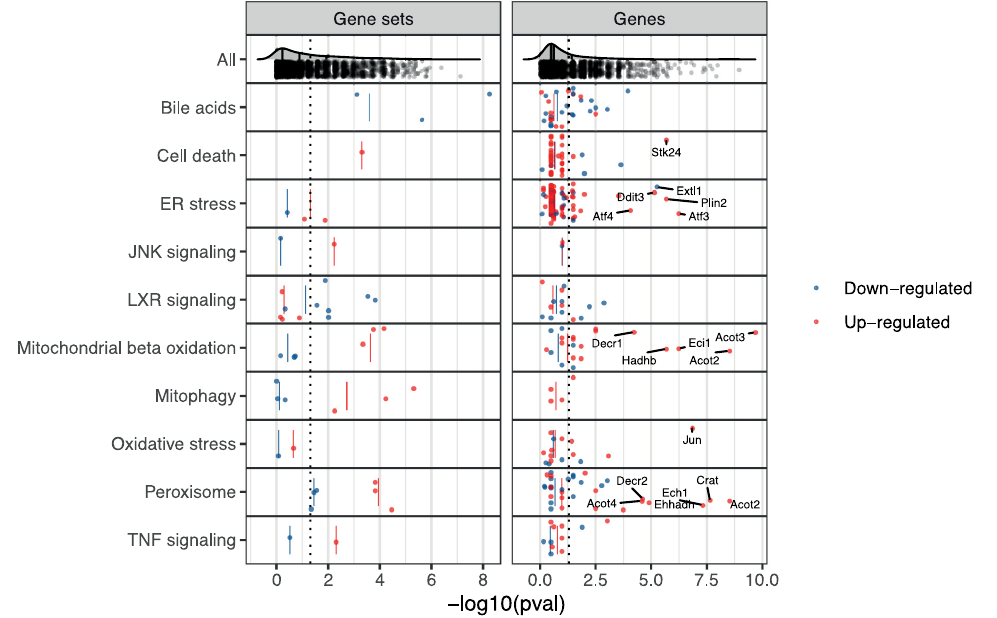
Fig 4. Enrichment of known events in DILI before adverse histopathology based on gene sets as well as individual gene members. The enrichment of first activation before or at adverse histopathology is shown for gene sets mapping to known key events in DILI, for which first activation was defined as first timepoint of differential GSVA-derived gene set activity. Furthermore, also enrichment of individual genes within these genesets is shown and was derived based on the first timepoints of differential expression. Aligning with the expected direction, a significant down-regulation of Liver X Receptor (LXR) signalling and bile acid-related pathways is observed, while all other gene sets were found to be more significantly up- regulated. Only for peroxisomal pathways, both directions were significantly enriched indicating that dysregulation in direction might be linked to adverse histopathology.